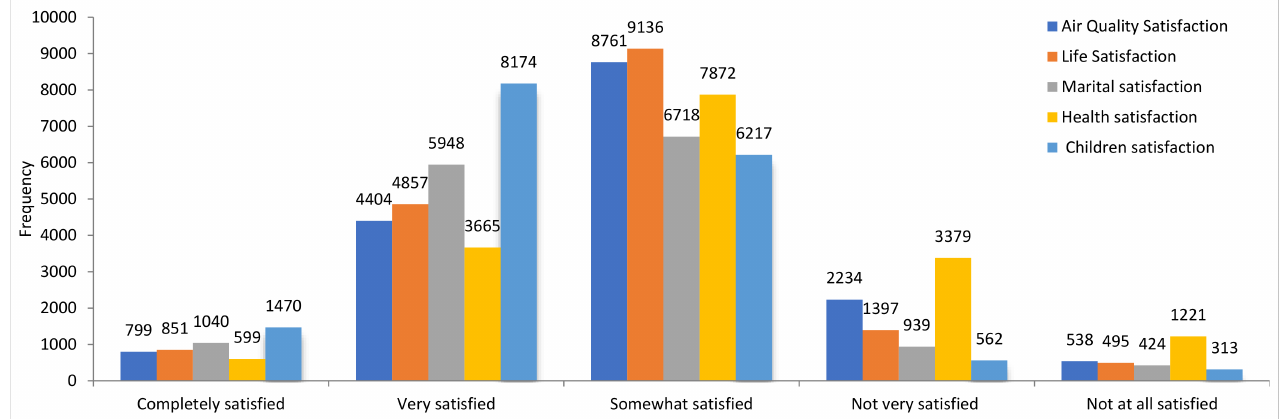
Figure 2. Satisfaction of various indicators of middle-aged and elderly residents in